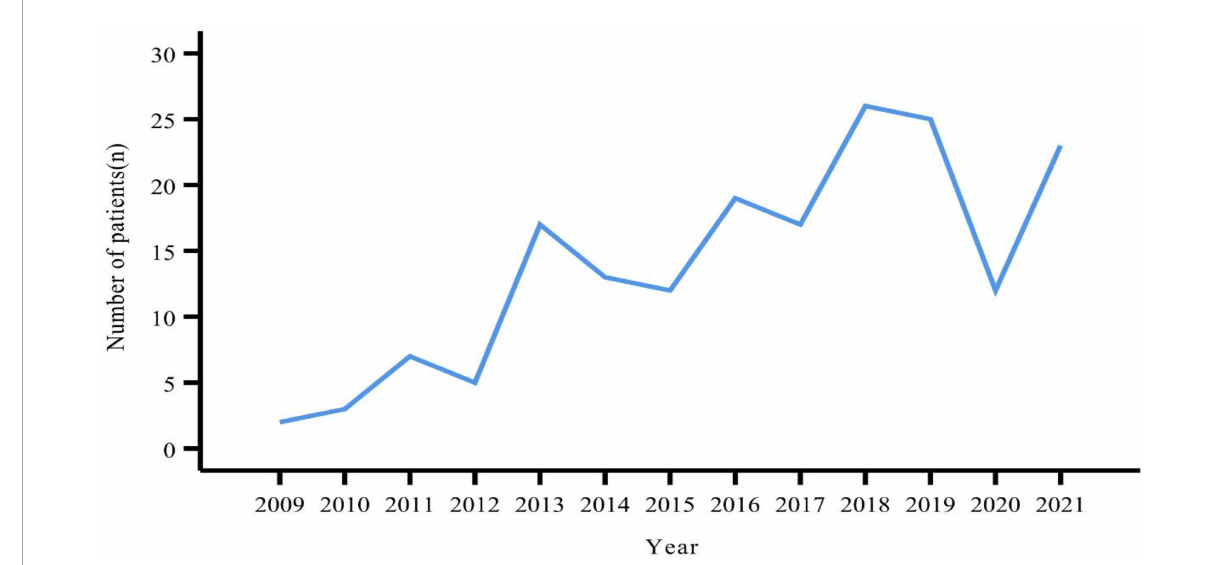
FIGURE1 Growing trends in the number of patients with pNENs from 2009 to